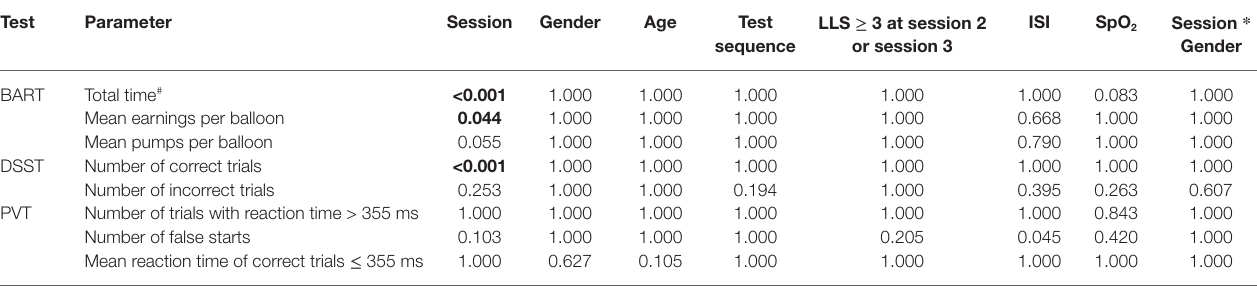
TABLE 4 | P -values of effects estimated by generalized estimating equations